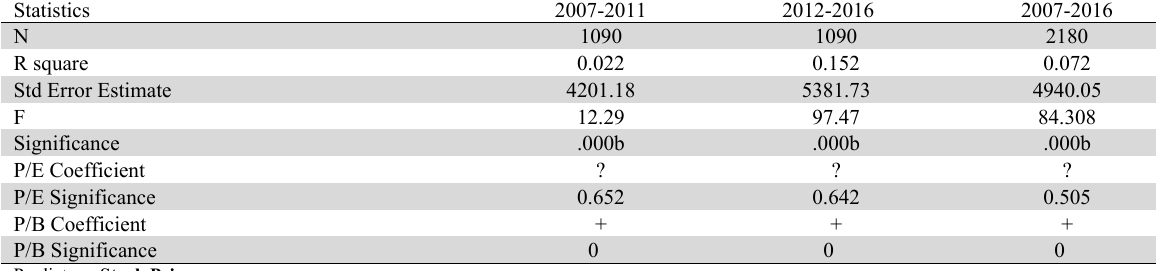
Statistical Analyses Result of period 2007-2011, 2012-2016, and 2017-2016